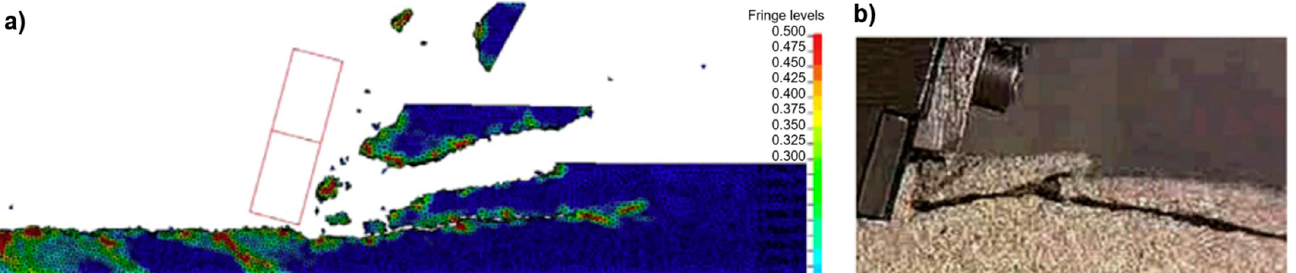
Figure 6. Comparison of the course of face destruction conducted by the FEM method and on a laboratory stand [37]: ( a ). FEM results, ( b ). laboratory tests (frame from high speed camera).